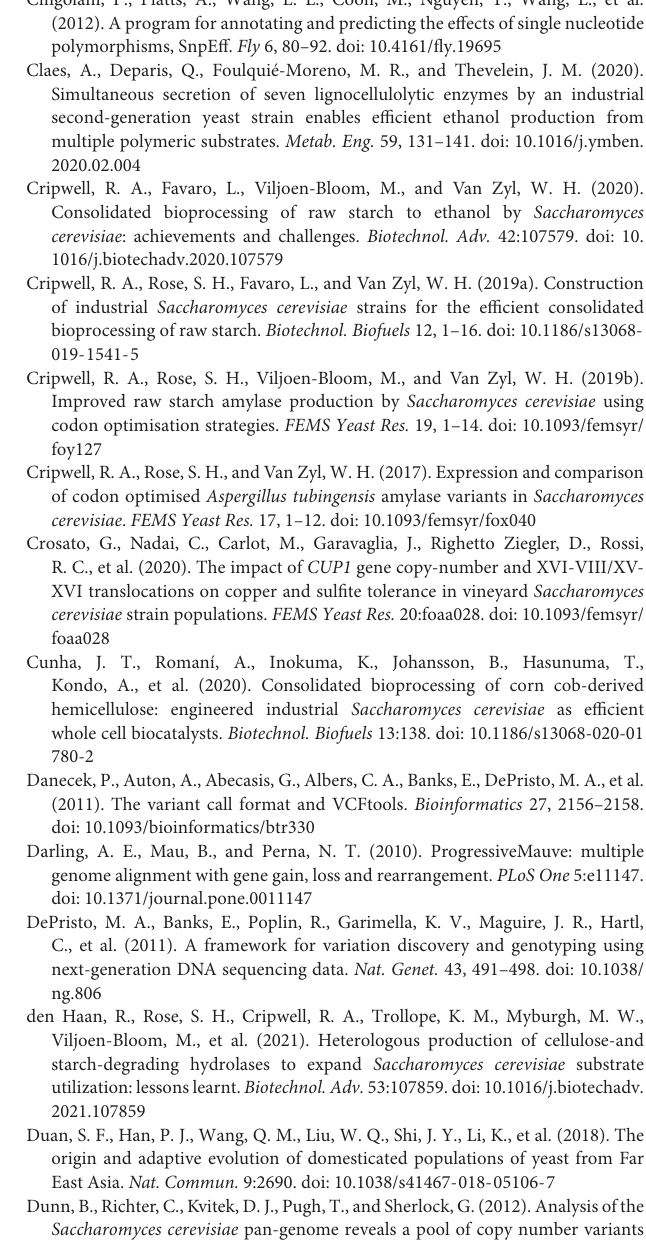
Supplementary Figure 1 | SDS-PAGE analysis of 72-h culture of recombinant S. cerevisiae Ethanol Red strains followed by silver staining. Arrows indicate the presence of recombinant protein species ( (cid:115) ) AmyA and ( (cid:52) ) GlaA in the supernatant. WT indicates the parental strain. The PageRuler Prestained Protein Ladder (Fermentas) was used as protein size marker